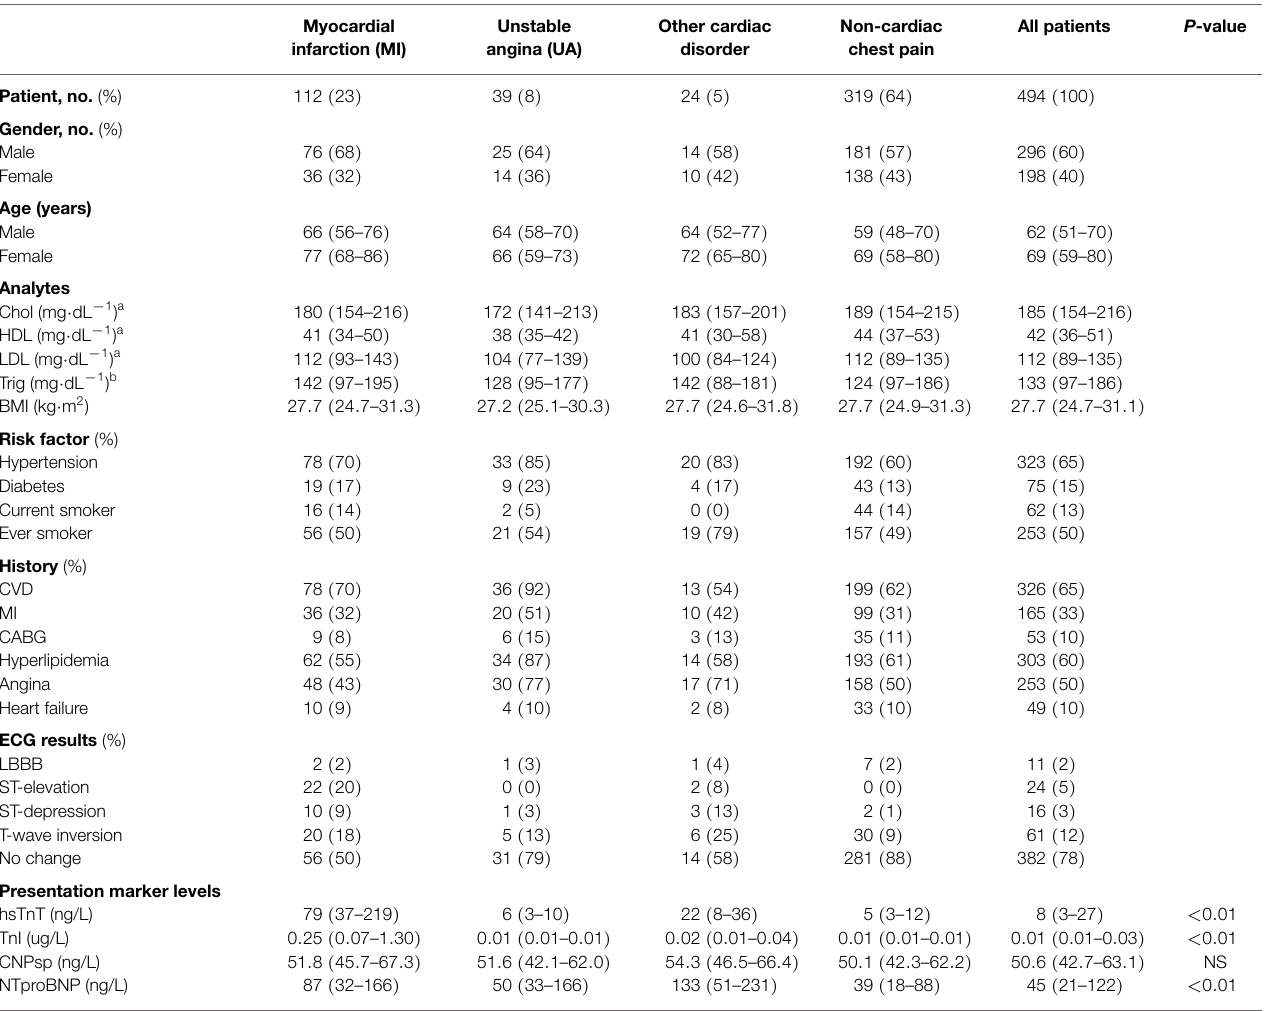
TABLE 1 | Baseline data for the prospective chest pain group (median, IQR, or percent) .